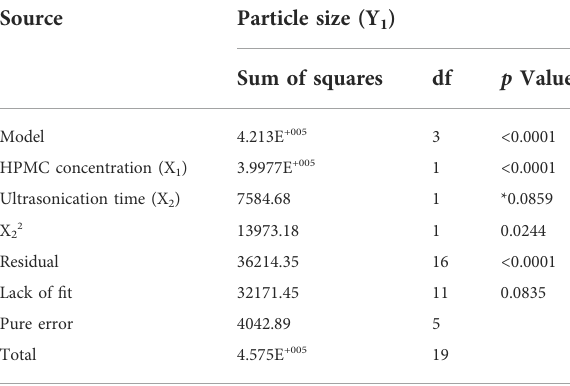
TABLE 2 Statistical output obtained from the ANOVA of regression model relating particle size with the three critical factors.